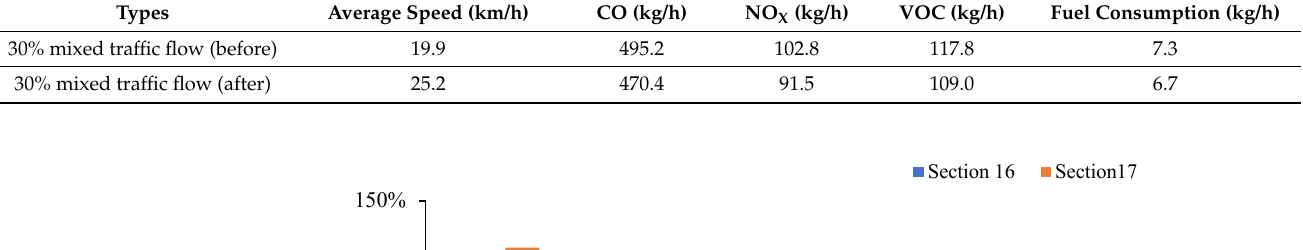
26 of 29 Table 5. Comparison results at the intersections. Types